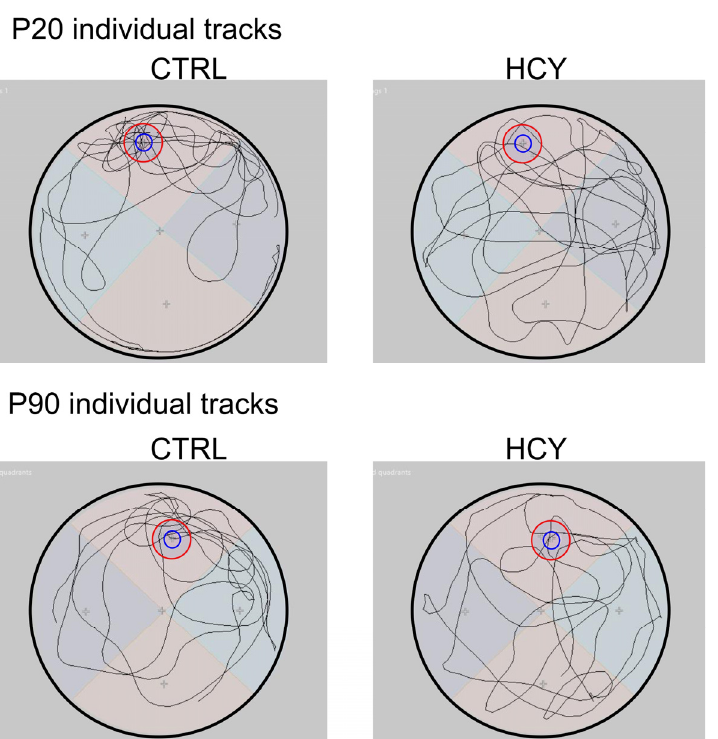
Figure A1. Representative examples of track in Morris water maze obtained at test trial. The blue circle indicates the position of the rescue platform during training sessions, the red circle is the area that was used to count the number of crossings.